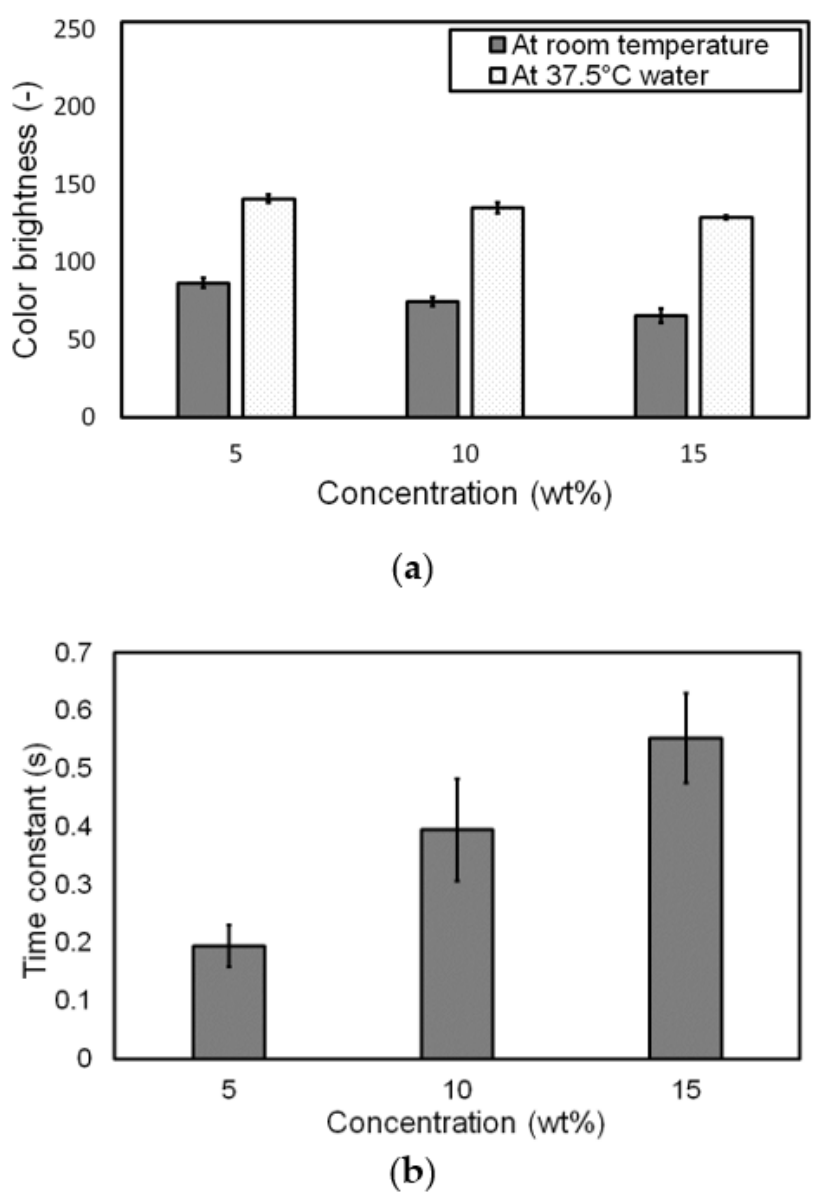
Figure 13. Analysis of color change behavior of the membranes with three different pigment con- centrations when they were soaked from air into warm distilled water (37.5 ◦ C): ( a ) change in color brightness and ( b ) time constant of color change. Table 3. Color brightness of the membranes at room temperature and 37.5 ◦ C and time constant during thermochromic reaction.